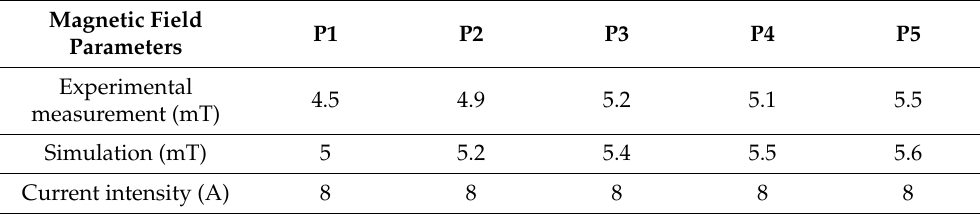
Figure 2. Maximal Lorentz force density as a function of ( a ) frequency, and ( b ) amplitude. Table 1. The magnetic field intensity B at the positions indicated by the dots in experimental setup measured with the Tesla meter and the simulation.